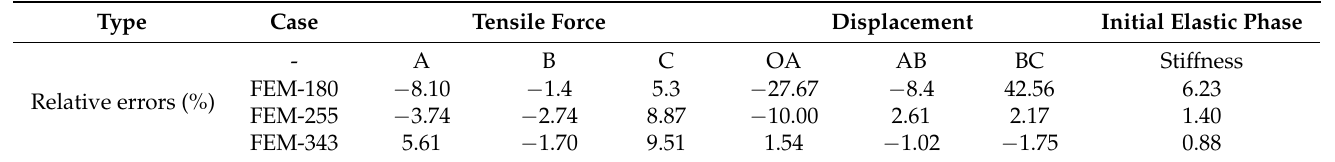
Table 8. Relative errors (%) of loading curve characteristics between Test 2 to 4 and the simulation.